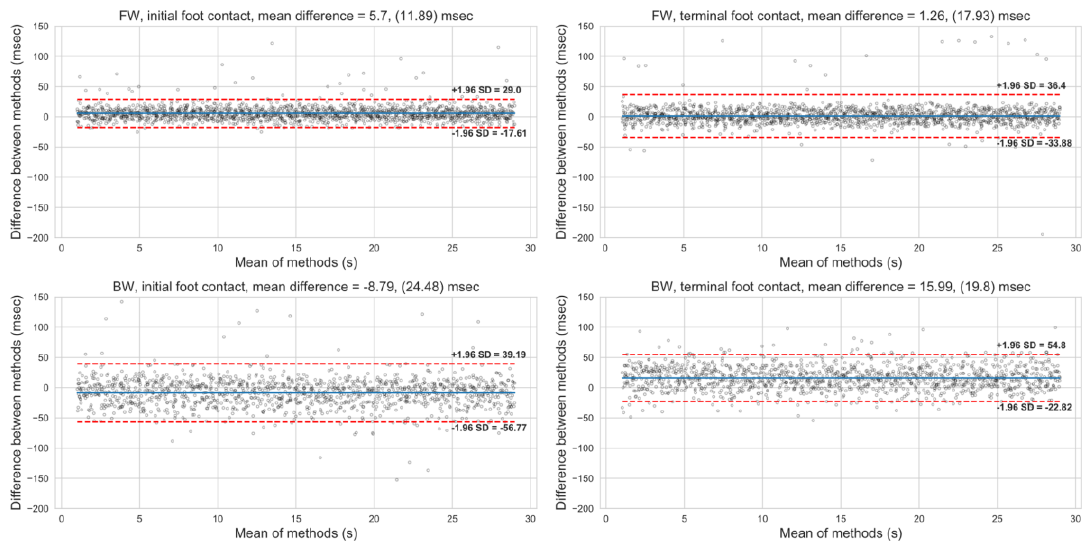
Figure 4. Bland – Altman limits of agreement between kinematic and accelerometry events identifications. FW: Forward walking; BW: Backward walking.